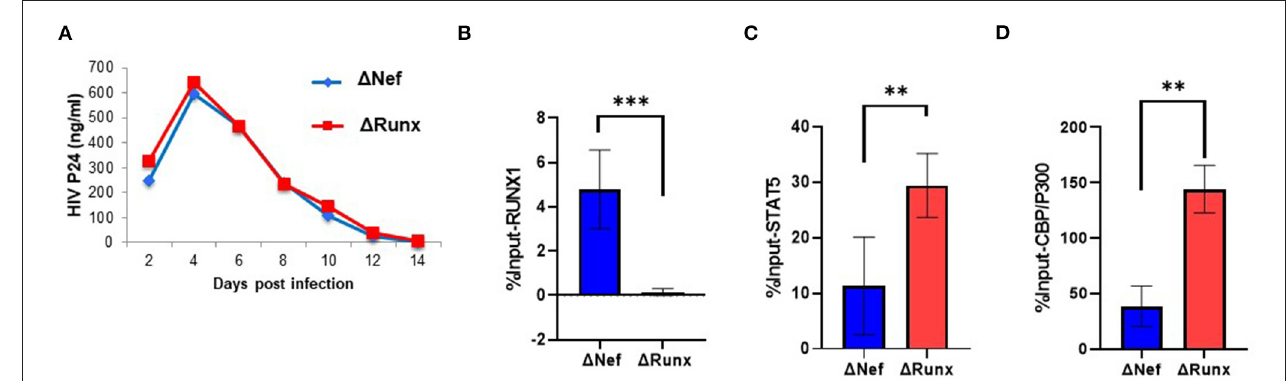
FIGURE 6 | Recruitment of STAT5 and CBP/P300 to the LTR in Primary Cells with RUNX1 binding inhibition. PBMC blasts from healthy donors were infected with 1 Nef or 1 RUNX. (A) Viral replication was followed over time by p24 ELISA. After 48h infection, PBMC cells were fixed and prepped for CHIP analysis with IP targeting (B) RUNX1 (C) STAT5 and (D) CBP/P300. ** P ≤ 0.01, *** P ≤